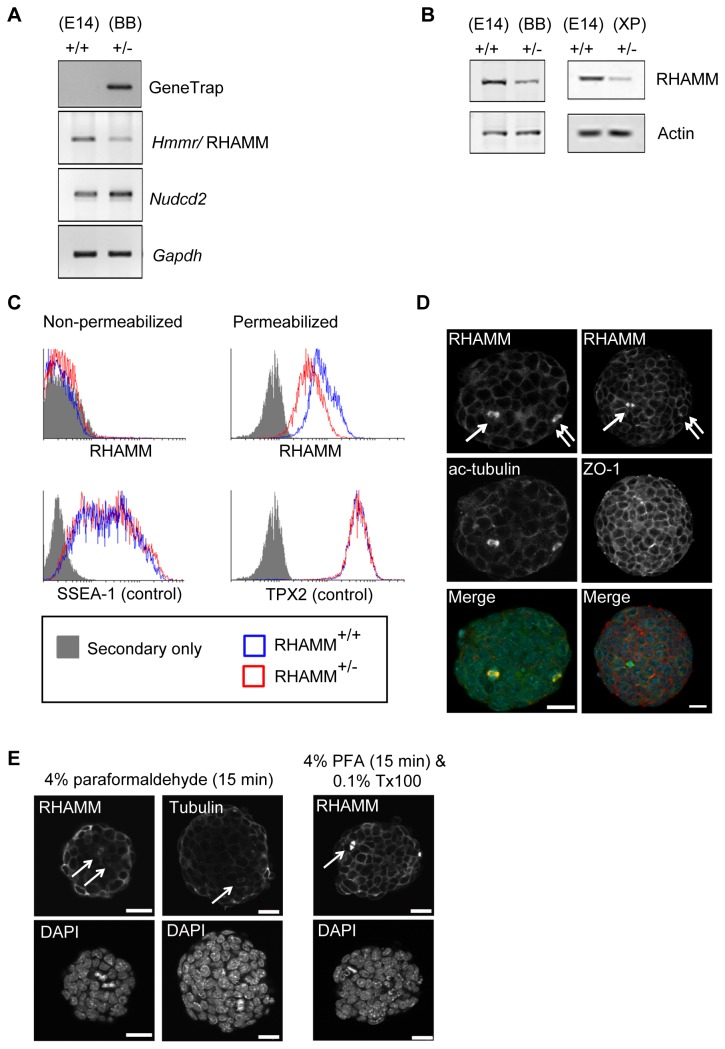
RHAMM is not a cell surface but an intracellular cytoskeletal protein in mouse embryonic stem (ES) cells.(A) Confirmation of the gene trap insertion and expression levels of RHAMM and Nudcd2 in parental (E14TG2; E14) and RHAMM+/- (BB0166; BB) mouse ES cells were measured by RT-PCR. GAPDH served as an internal control. Gene expression of RHAMM was reduced in RHAMM+/- cells whereas Nudcd2 was unaffected by the gene trap insertion. (B) Western blot analysis revealed a marked reduction of RHAMM protein in RHAMM+/- mouse ES cells (BB0166). Similar reduction of RHAMM was observed in an alternate RHAMM+/- mouse ES cell-line, XP0038. Actin served as a loading control. (C) Fluorescence activated cell sorting (FACS) of non-permeabilized (left panel) mouse ES cells failed to detect extracellular RHAMM using a C-terminal directed antibody. Similar results were obtained with an N-terminal directed antibody (not shown). Relative to negative control secondary antibody only, both cell-lines were strongly positive for SSEA-1. Alcohol permeabilized mouse ES cells, however, were strongly positive for both RHAMM and the intracellular positive control protein TPX2 (right panel). (D) Immunofluorescence detection of RHAMM in RHAMM+/+ mouse ES cells co-localized with microtubules (acetylated tubulin; ac-tubulin) and cell-cell junctions (ZO-1). Arrows indicate co-localization with mitotic spindles, while double arrows indicate co-localization with mitotic centrosomes. Scale bar: 20 µm. (E) RHAMM+/+ mouse ES cells grown without feeders were fixed in 4% paraformaldehyde and stained with antibodies to either RHAMM or beta-tubulin. The arrows point out mitotic spindles that stain positive despite the lack of detergent in the fixation procedure. Addition of detergent (0.1% Triton X-100) to the methodology results in significantly better penetration of the antibodies and amplification of the detected signal. Scale bar: 10 µm.